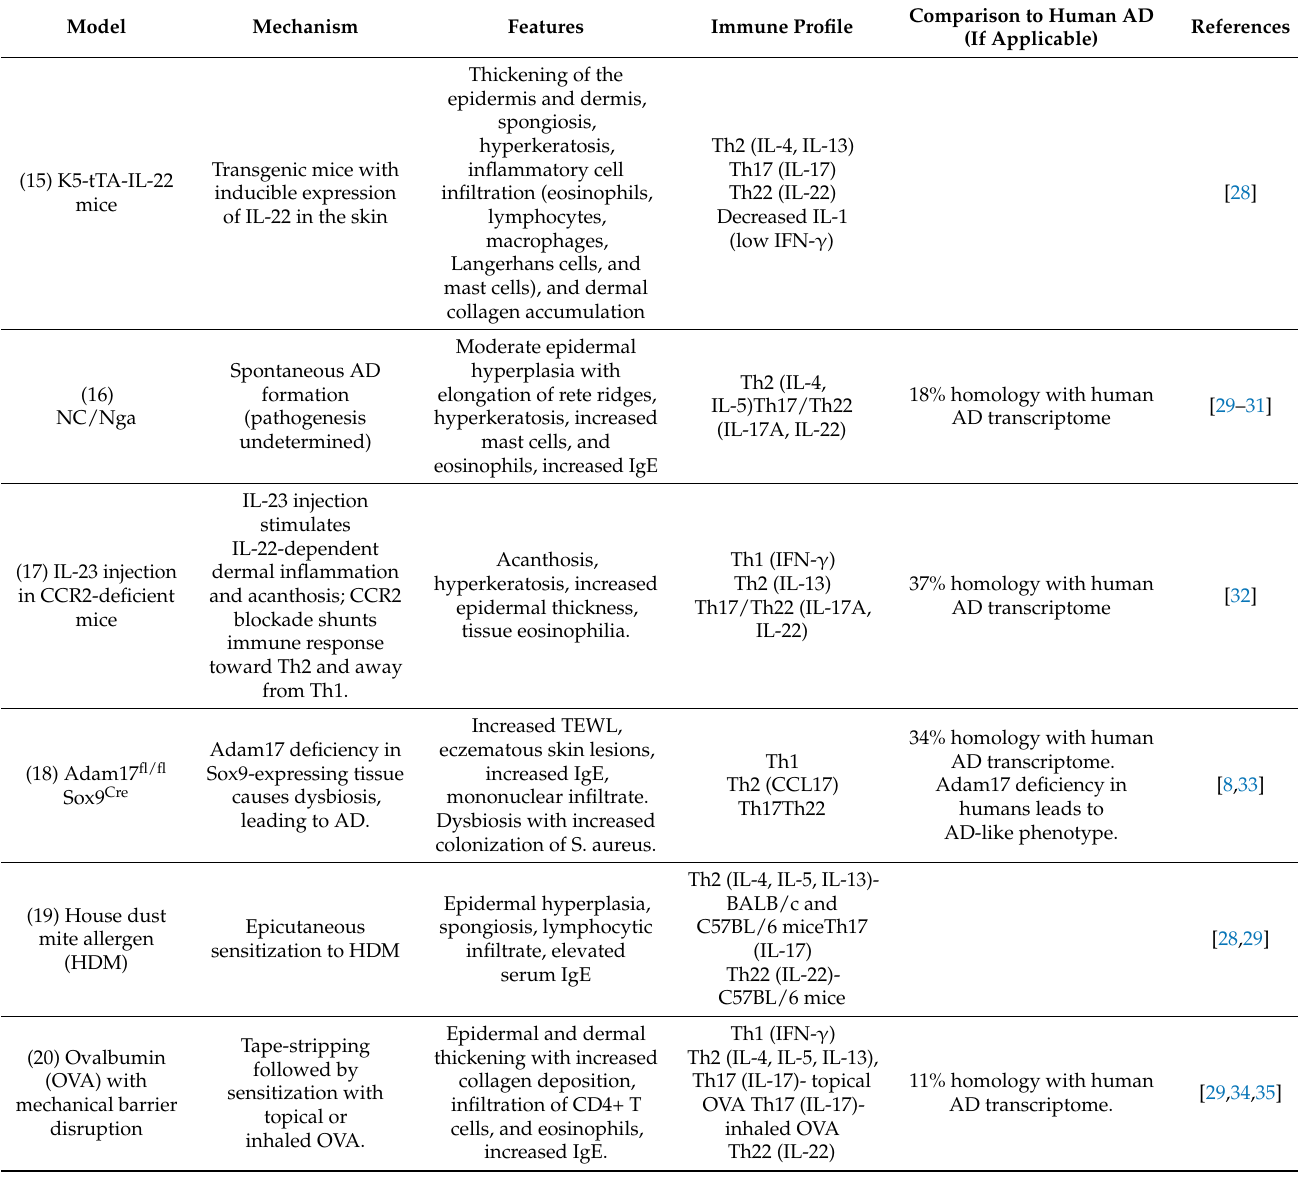
Table 3. Th2 and/or Th1, Th17, or Th22